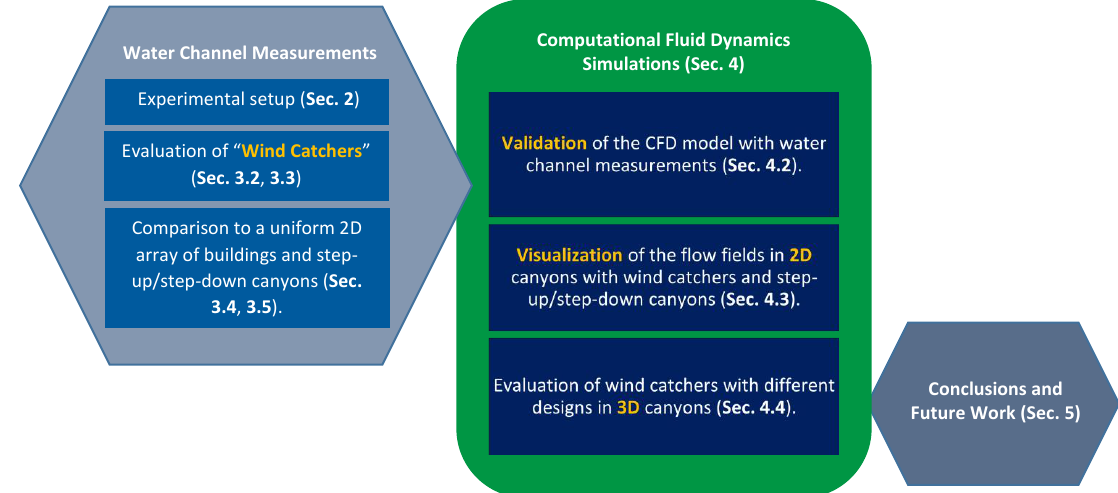
Figure 1. The flow chart and methodology of the current